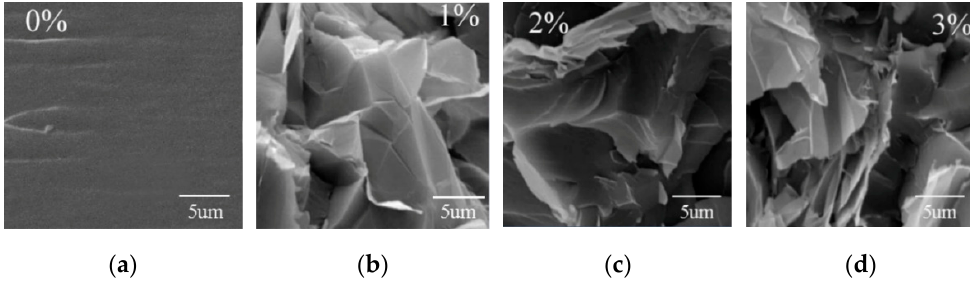
Figure 4. SEM of the graphene/H-EP composites. ( a ) Pure H-EP resin; ( b )1 wt % graphene/H-EP; ( c ) 2 wt % graphene/H-EP; ( d ) 3 wt % graphene/H-EP.